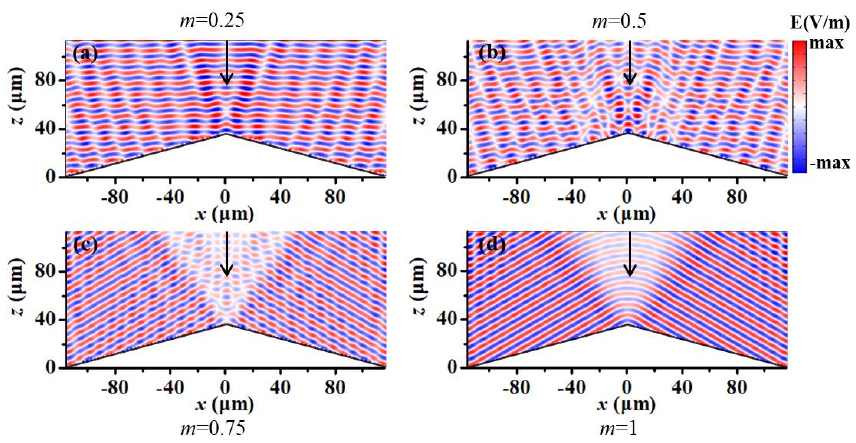
Figure 5. GSST state-dependent cloaking performance of our design under normal incidence. Simu- lated reflected E-field distributions in the x–z plane for our scheme with different crystallization levels of m = 0.25 ( a ), 0.5 ( b ), 0.75 ( c ) and 1 ( d ) upon LCP illuminance with λ 0 = 7.9 µ m nm, respec- tively.